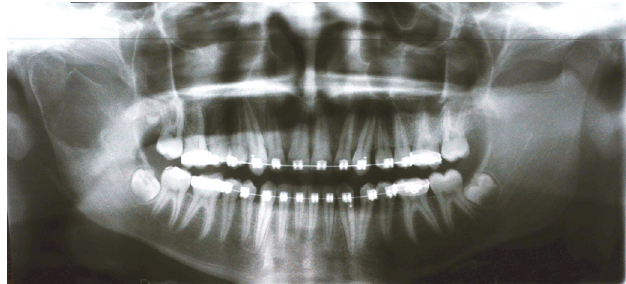
Fig. 1. Orthopantomogramm P1 shows a brightening and infracture in the right condyle.